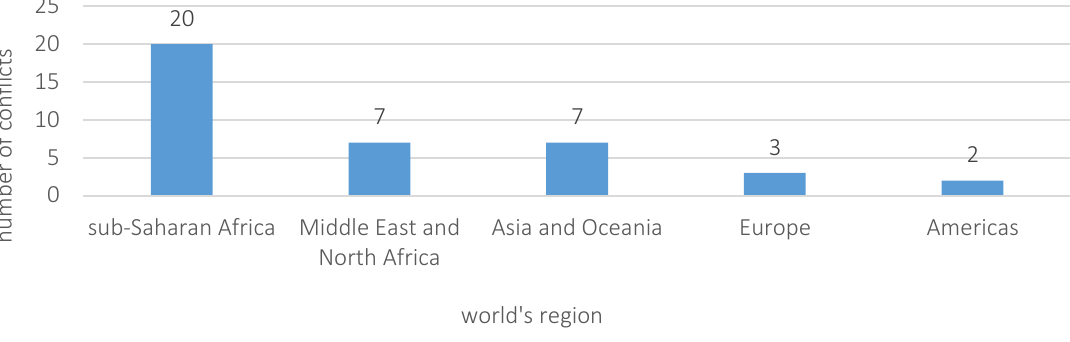
Figure 1. The number of military conflicts in 2020 by regions of the